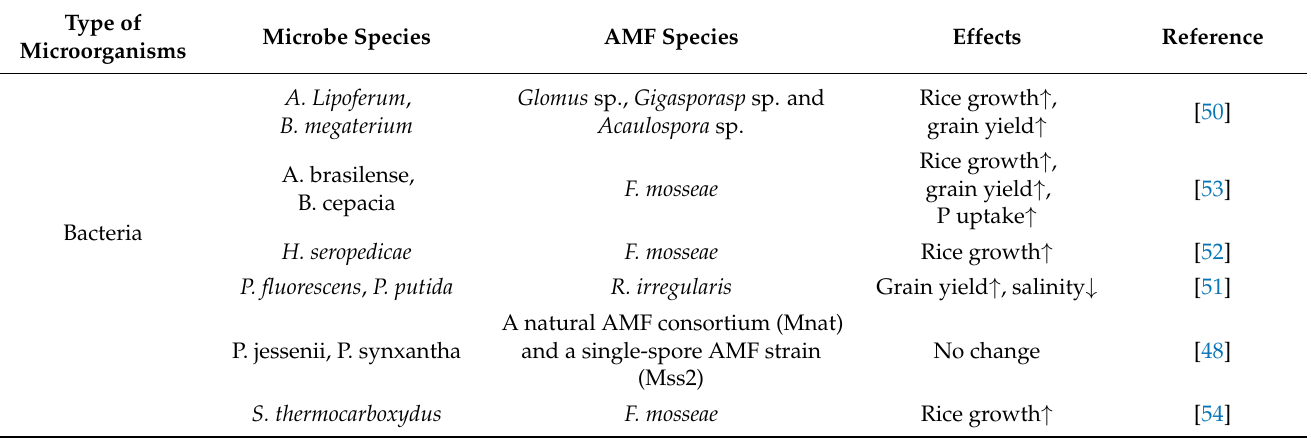
Figure 1. Schematic view of interactions between AMF and different components of the mycorrhizosphere. Table 1. List of major microorganisms interacting with AMF in rice